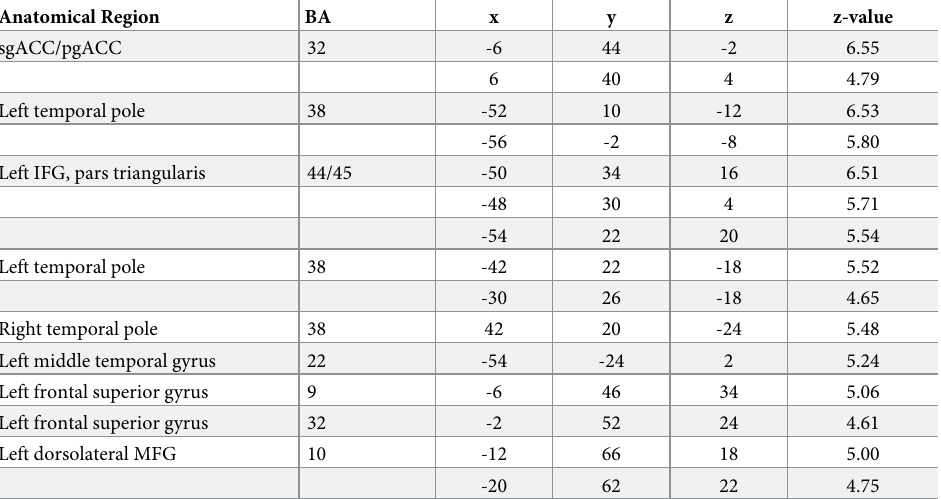
Table 2. Main effect: Exclusion minus inclusion in the Cyberball game. Anatomical Region